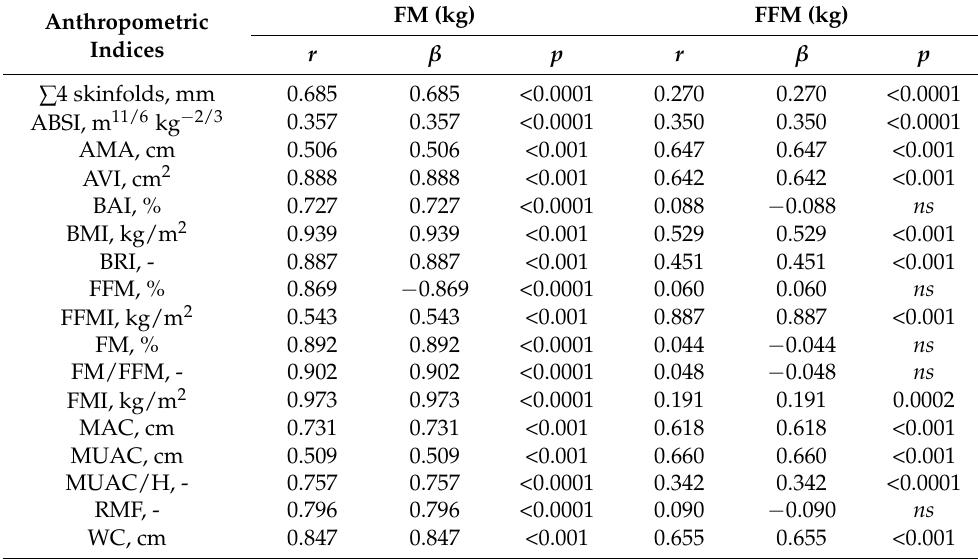
Table 3. Correlation between FM or FFM and anthropometric